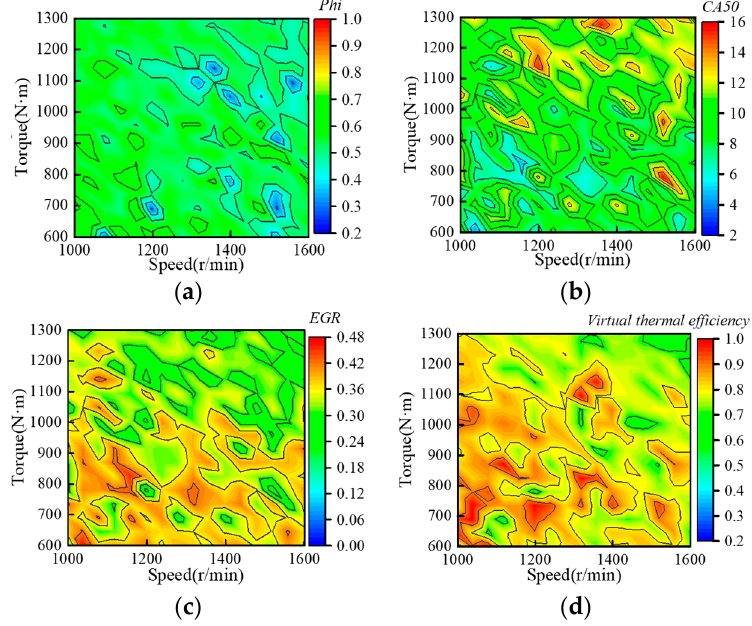
Figure 11. ( a ) Phi ( b ) CA50 ( c ) EGR ( d ) Virtual thermal efficiency. Optimizing results based on the genetic algorithm.